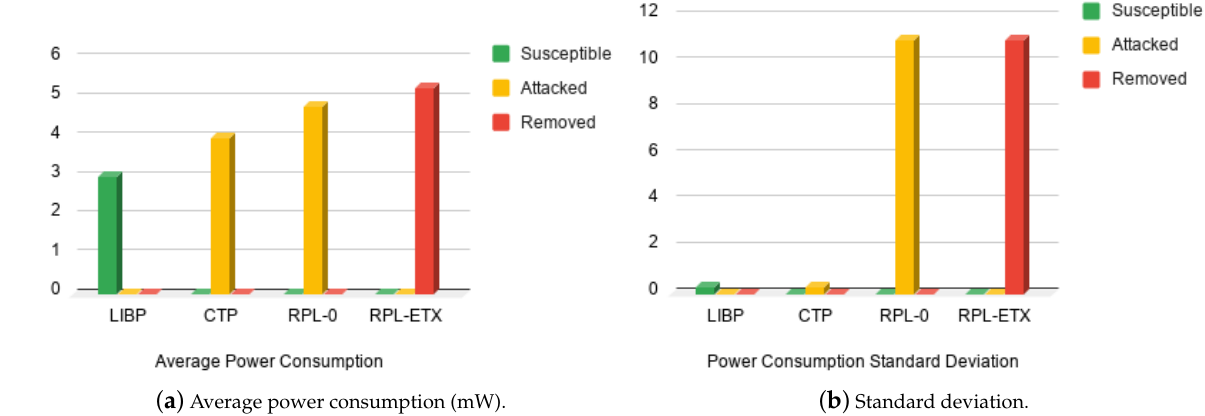
Figure 9. Energy profile: Average power